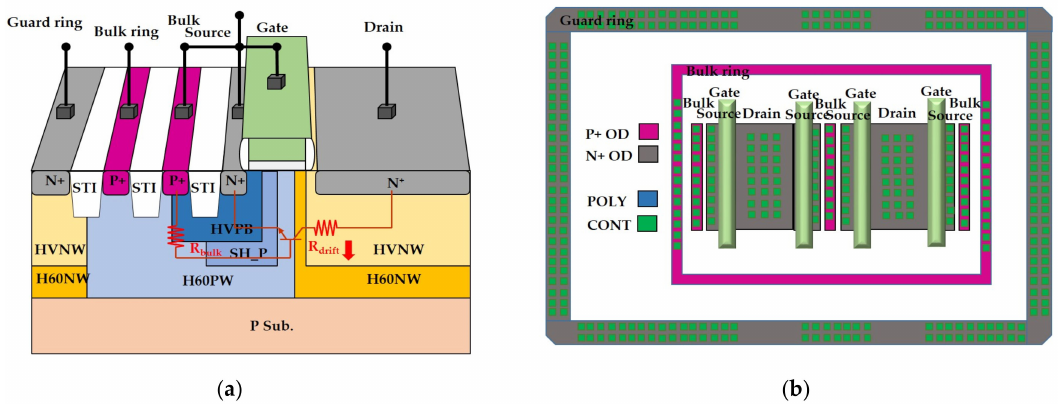
Figure 2. ( a ) 3D structure view; and ( b ) layout view of the HV nLDMOS with the shortest (STI 0)